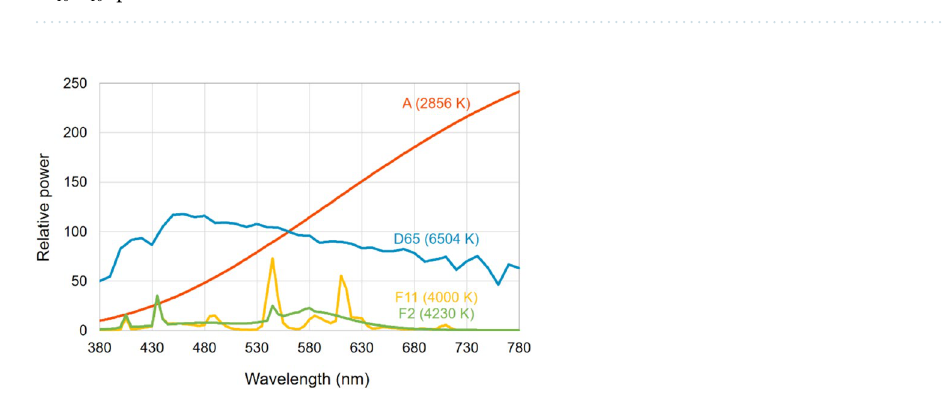
Figure 2. Distribution of 72 samples in the CIELAB color space under the illuminant D65: ( a ) L * 10 and ( b ) a *